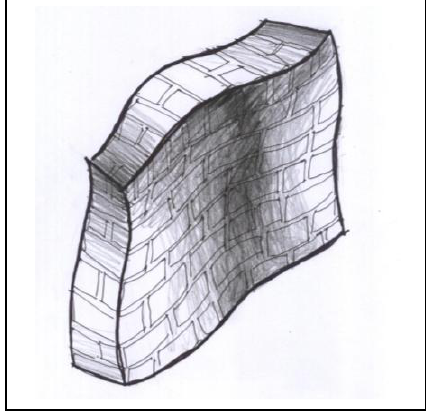
Figure 3: The deformation in a curvilinear form, since the material is tired and is bending with the load ( March